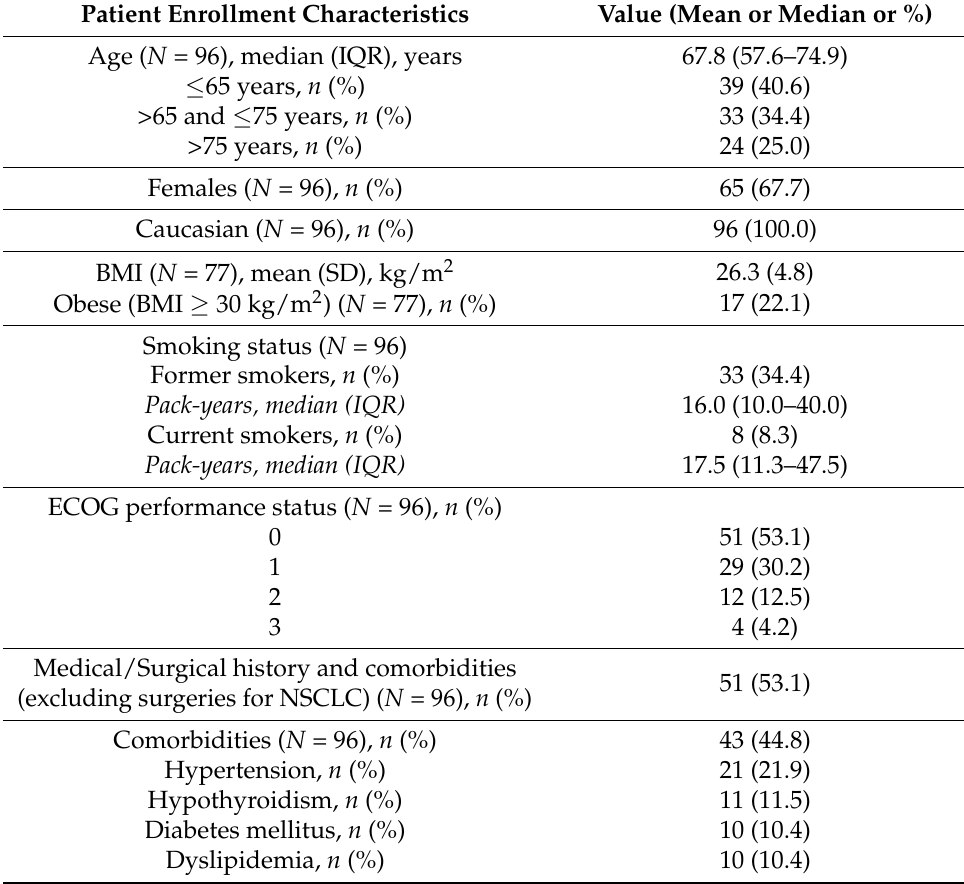
Table 1. Patient characteristics at enrollment.